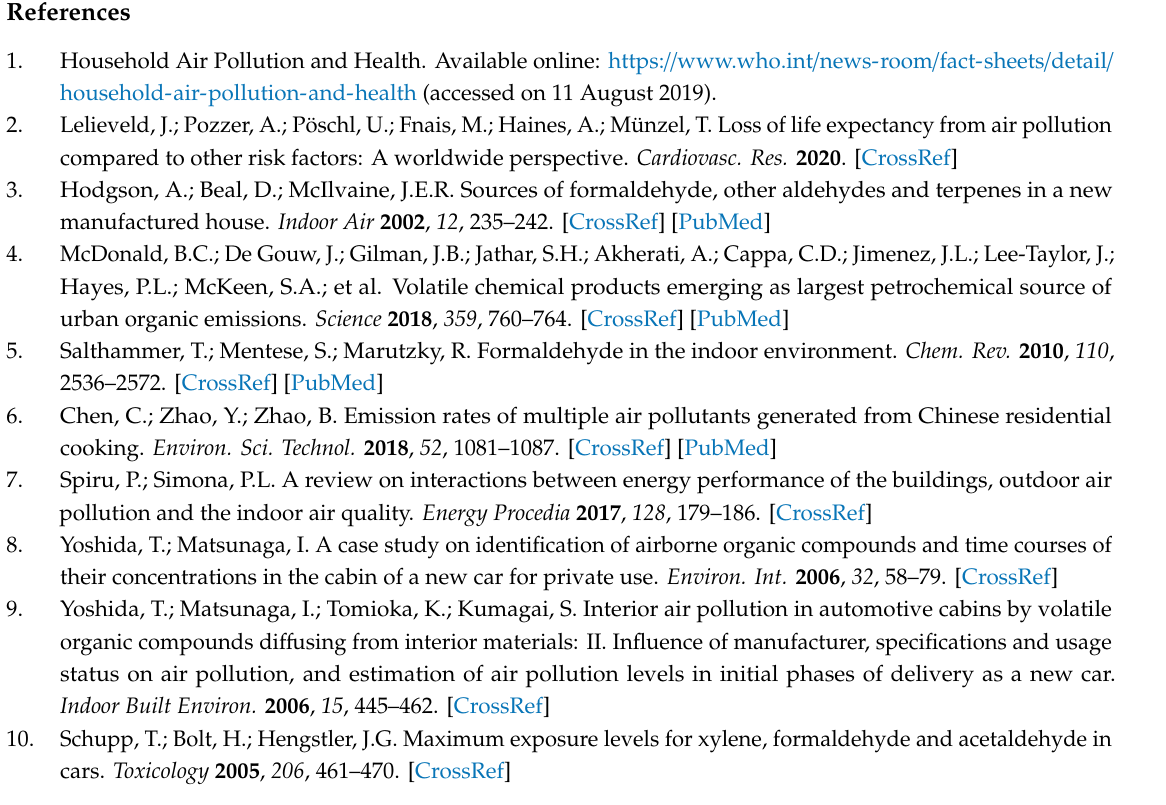
Table S2: Testing conditions and removal e ffi ciencies for HCHO single-pass removal tests conducted with the CRDS in Figure 2, panel 1, Table S3: Testing conditions and removal e ffi ciencies for HCHO single-pass removal tests conducted with the CRDS in Figure 2, panel 2, Table S4: Averaged testing conditions and removal e ffi ciencies for NO2 single-pass removal tests, Table S5: Testing conditions for chamber removal tests, Table S6: Mean and standard deviation of CRDS zero air tests, Table S7: Values calculated from nitrogen adsorption and desorption isotherms, Table S8: Experimental uncertainty contribution from di ff erent sample